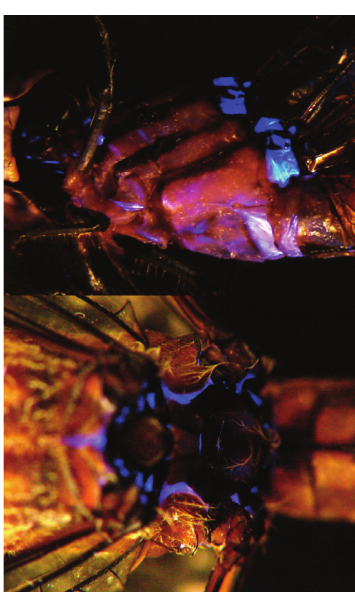
Figure 4: Blue fluorescence in UV light on Acinia picturata (Diptera: Tephritidae) (top) and Minettia flaveola (Diptera: Laux- aniidae) (bottom). Color intensity digitally increased.